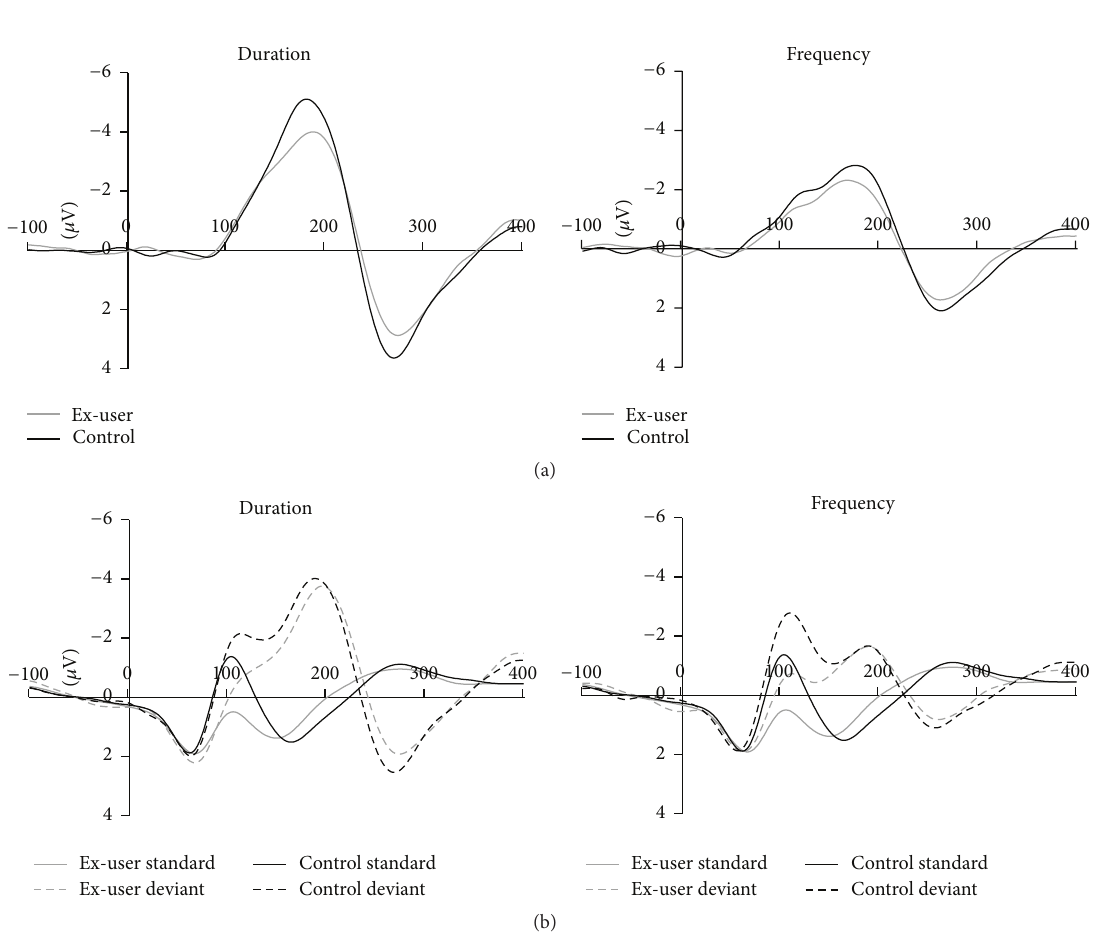
Figure1:(a)Mismatchnegativity(MMN)waveformsatFzdisplayedforeachconditionforex-cannabisusers(greyline)andnonusercontrols (black line). (b) Mastoid reference unsubtracted ERP waveforms at Fz to standard (solid line) and deviant tones (dashed lines) for ex-cannabis users (grey lines) and nonuser controls (black lines). Amplitude is shown in 𝜇 V on the 𝑦 -axis and time in milliseconds along the 𝑥